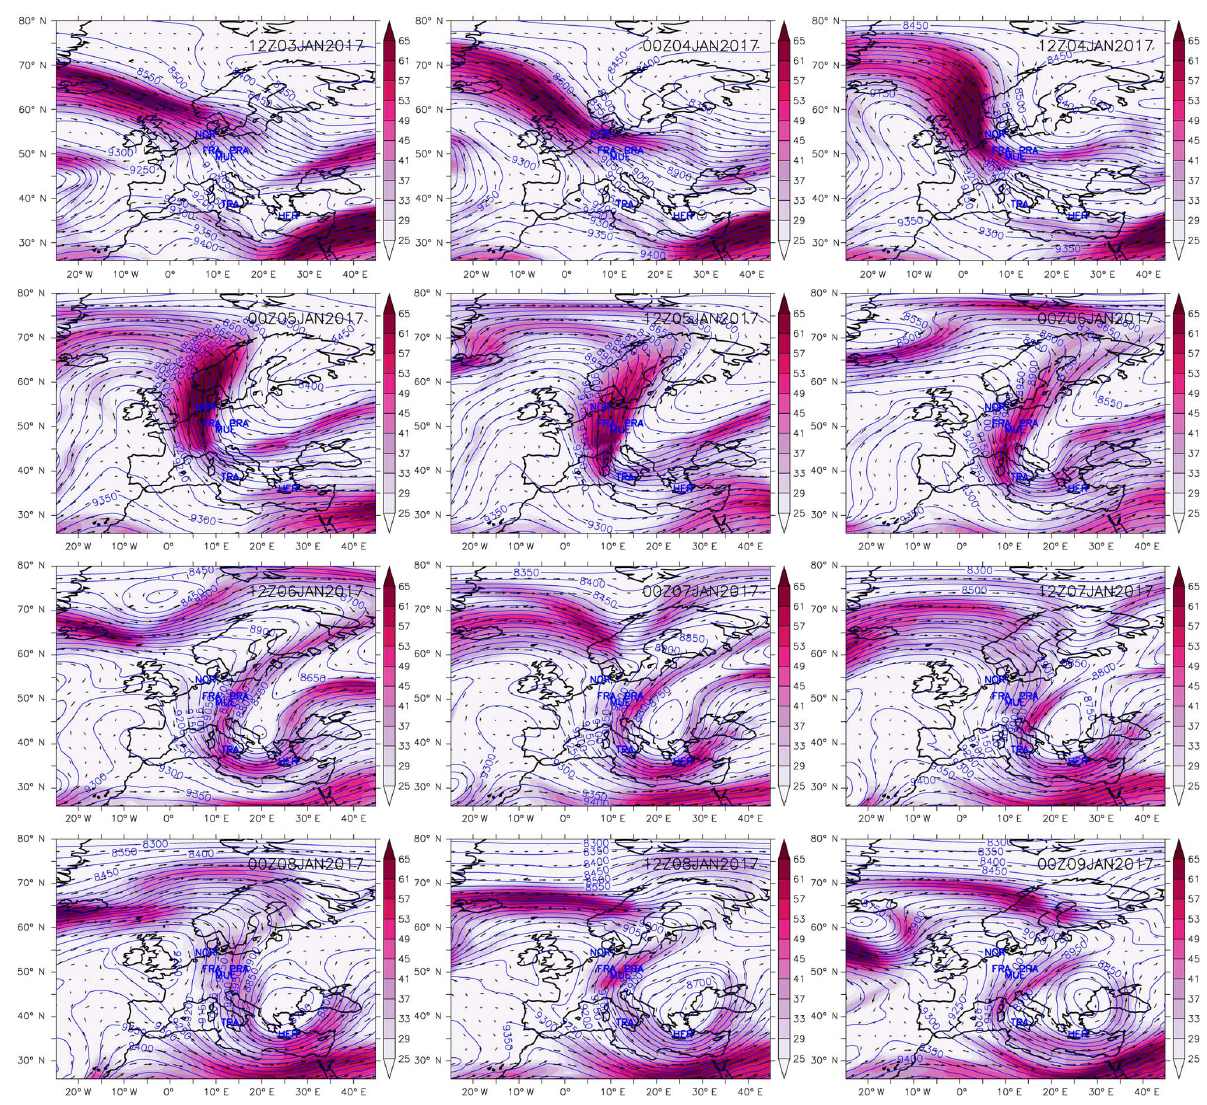
Figure 1. IFS geopotential height (in gpm; contours), wind speed (in ms − 1 ; colour shaded) and wind direction (vectors) at 300hPa, during the period from 12:00Z on 3 January 2017 to 00:00Z on 9 January 2017 (12h interval). Also shown are the locations of the observational sites (blue text) used in the